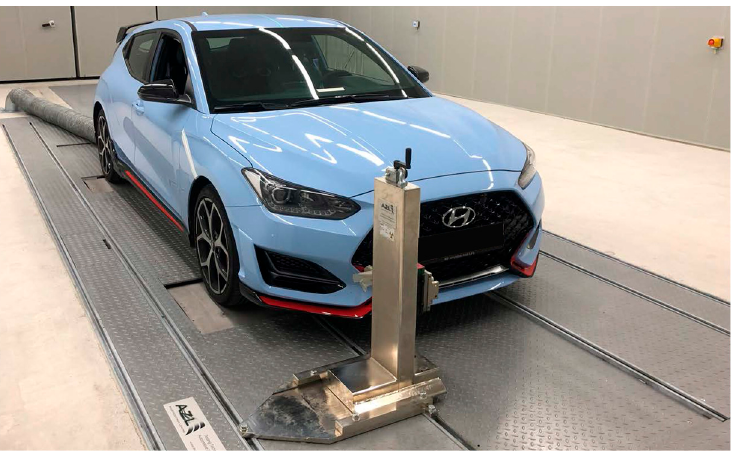
Figure 13. Roller bench test rig to secure the reliability and repeatability of the ride comfort test.